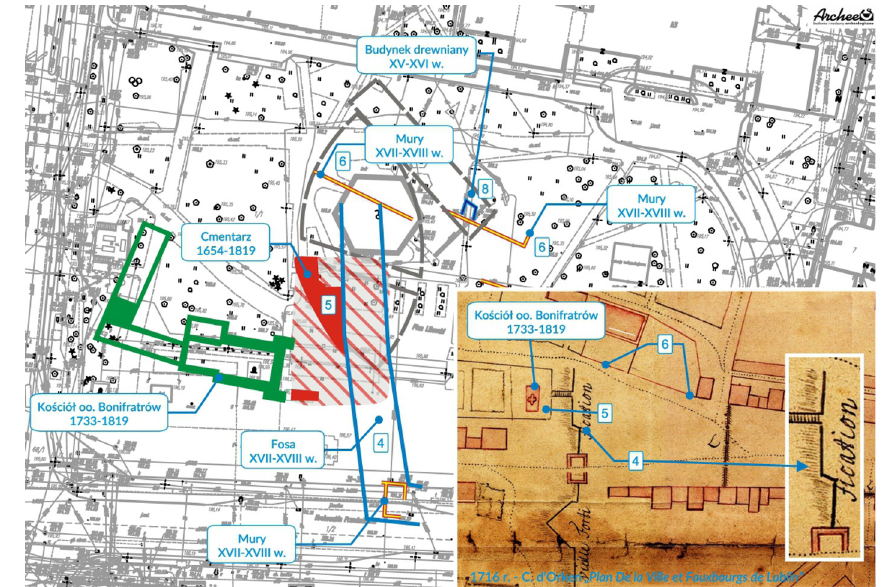
Fig. 6. The results of the archaeological research on Litewski Square combined with objects of d'Örken’s map (prepared by ARCHEE), numbers mark the corresponding objects from the 1716 map and the contemporary basic map; descriptions from top to bottom: Wooden building 15th−16th c., Walls 17th−18th